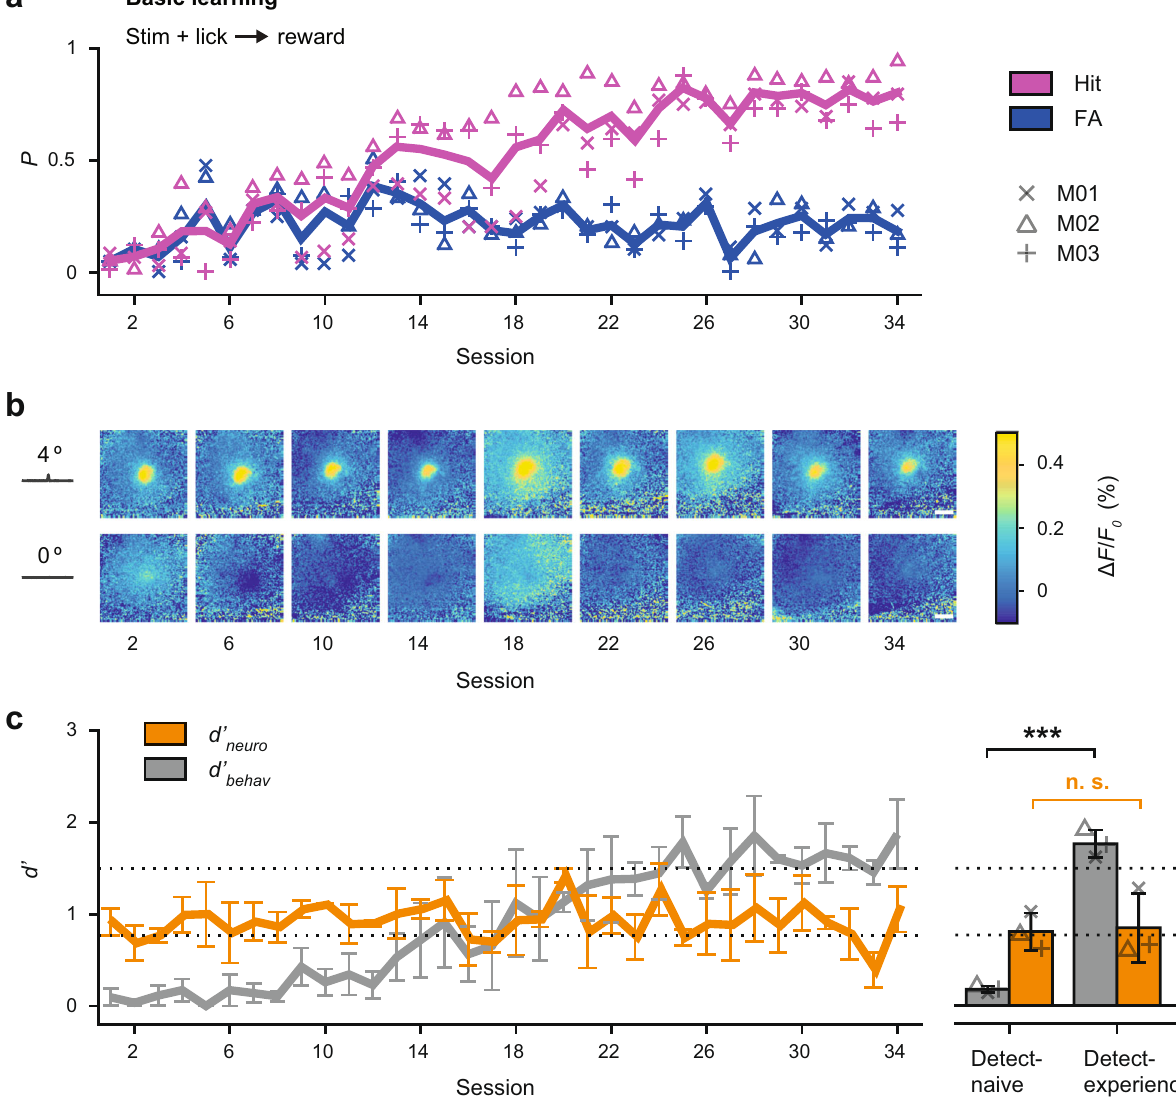
Fig. 2 Basic learning and sensory signals in S1. a Learning curve for 3 mice trained on the basic Go/No-Go detection task with a weak stimulus (4 degree). Performance is expressed as the probability of a hit (lick after stimulus) and false alarm (lick after no stimulus) for a given session. Individual mice are represented by symbols and the mean by bold lines. b Fluorescent activity in S1 from an example mouse during learning of the task. Shown are frames at the peak response to the 4 degree stimulus, catch trials are shown below. Scale bar: 1 mm. c Dprime metrics for both behavioral and neuronal data during learning of the task. The d ’ behav was calculated from the observed hit rate and false alarm rate for a given training session. The d ′ neuro was calculated by comparing single-trial distributions of all evoked signal peaks (maximum % Δ F / F 0 within 100 ms post stimulus) with the corresponding noise distributions when no stimulus was present. Shown are means across mice ( n = 3) for a given session, error bars represent bootstrapped estimates of 95% con fi dence limits ( n = 1000 repetitions). The dotted lines separate performance into “ detect-naive ” ( d ′ < 0.8), and “ detect-experienced ” ( d ′ > 1.5). The right panel shows the same data separated for individuals (symbols) before and after learning. Bars represent means across mice, error bars represent SD ( n = 3). *** P < 0.001, n.s. not signi fi cant, P = 0.63, two-sided Wilcoxon rank-sum